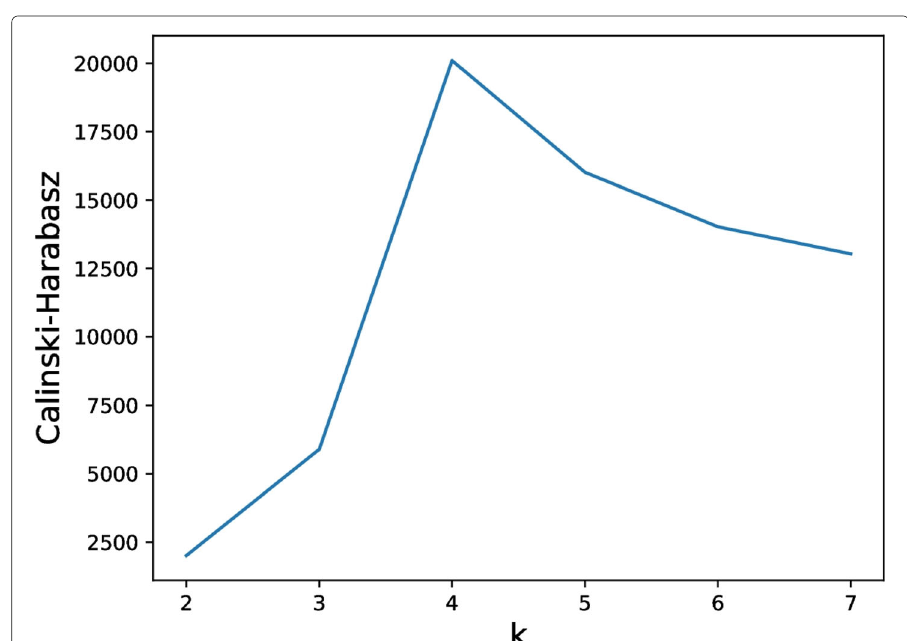
Fig. 5 Calinski-Harabasz changes with the value of